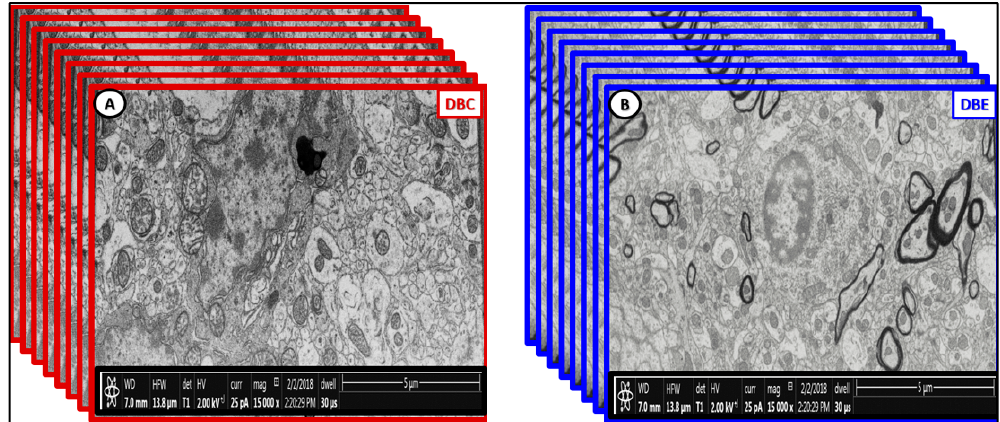
Figure 13. Stacked fixed images of diabetic DBC (outlined red) and EMPA-treated DBE models (outlined blue). The front pre-run images are labeled in Figure 12. The images in this figure are to demonstrate how Video S1 was created by utilizing approximately 250 stacked sliced images every 20 nm in order to create the Supplementary Materials DBC [2] and DBE video (Video S1). Scale bar = 5 µm.